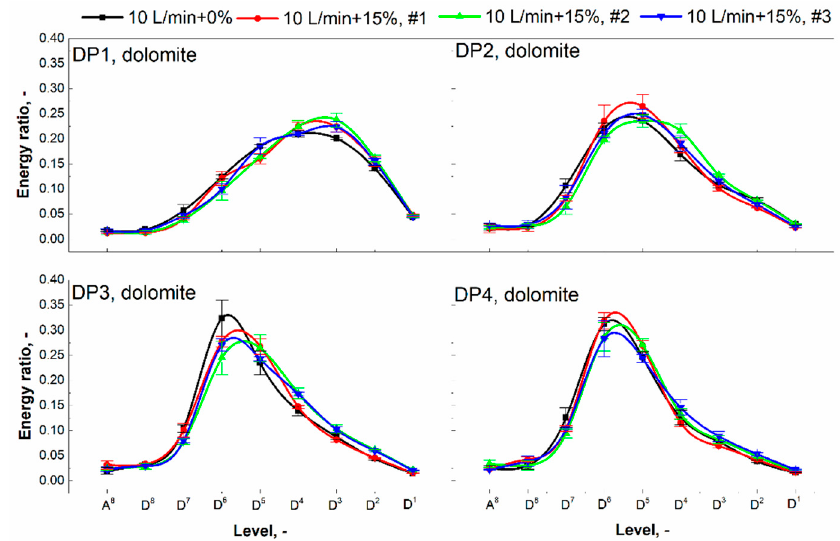
Figure 11. Effects of the gas addition location on the energy distribution profiles of multi-scale resolved differential pressure signals from DP1~DP4. The other operational conditions were: T = 550 ◦ C, P = 0.1 MPa, H ini = 1.28 m, U = 0.09 m/s, addition rate = 1.5 L/min, calcined dolomite.